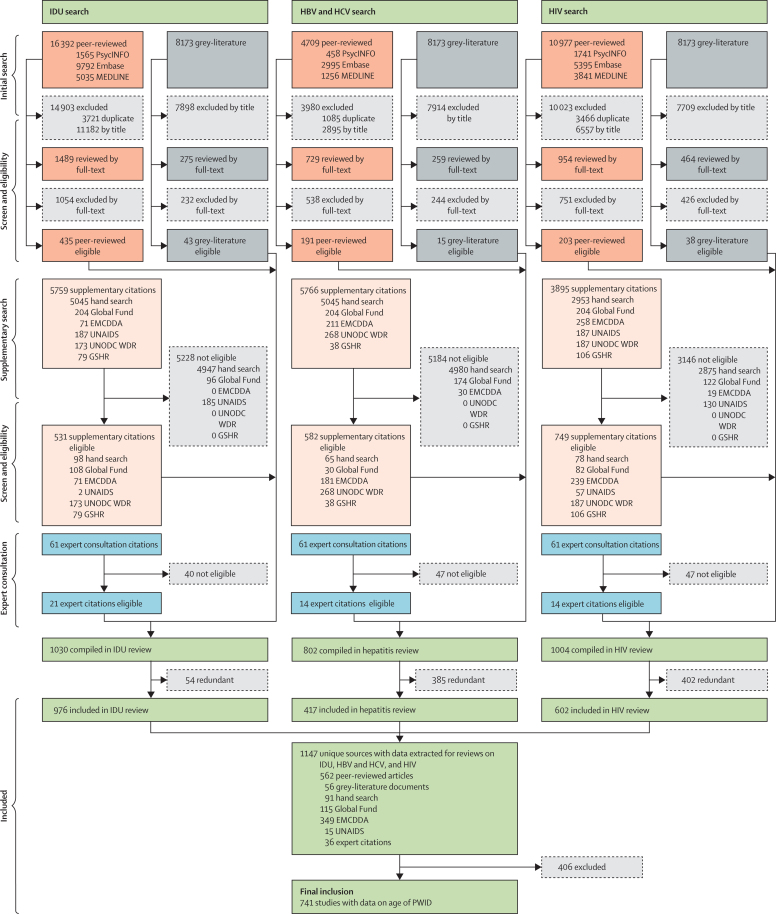
Flowchart of study inclusion criteriaAdapted from Degenhardt and colleagues.1 EMCDDA=European Monitoring Centre on Drugs and Drug Addiction. GSHR=HRI's Global State of Harm Reduction. HBV=hepatitis B virus. HCV=hepatitis C virus. IDU=injecting drug use. PWID=people who inject drugs. UNODC WDR=UN Office on Drugs and Crime's World Drug Report.